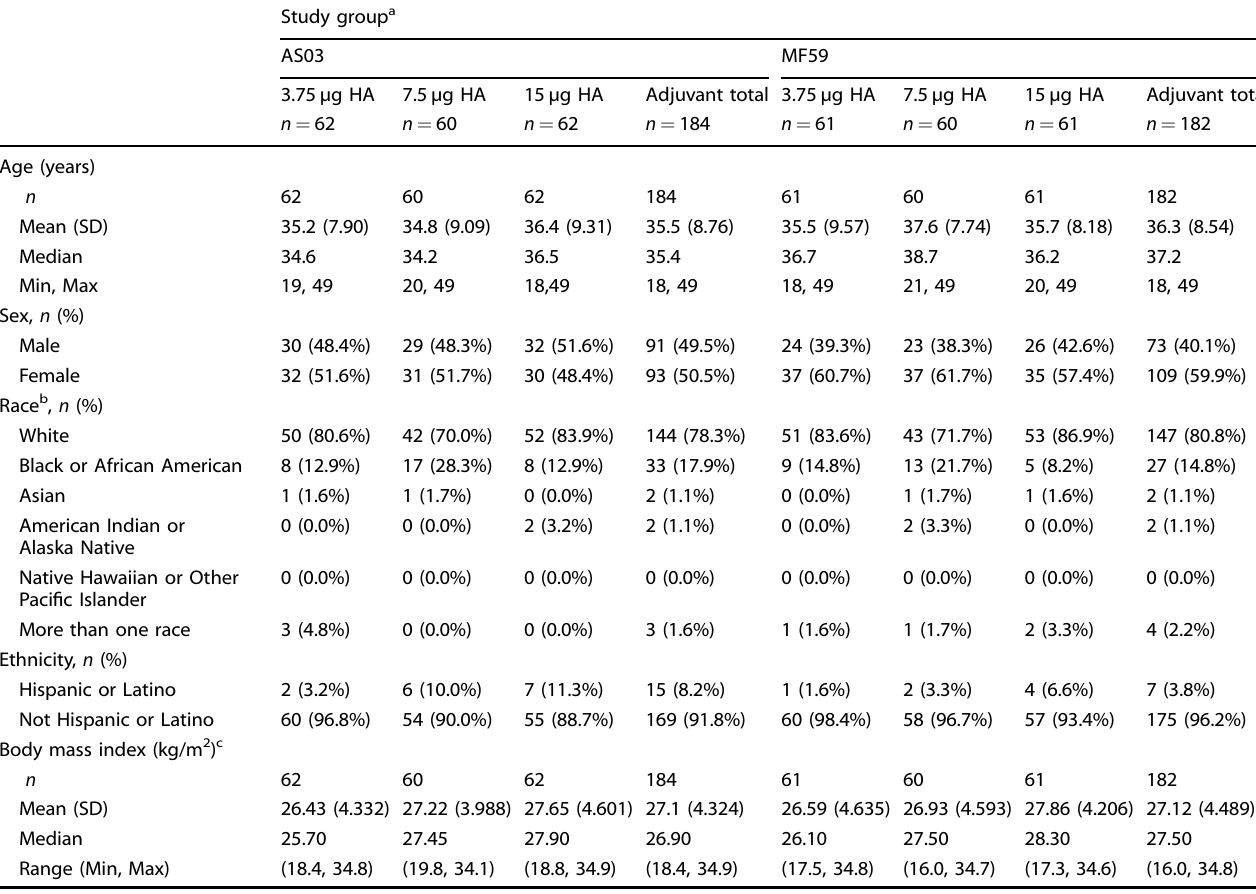
Table 1. Safety population